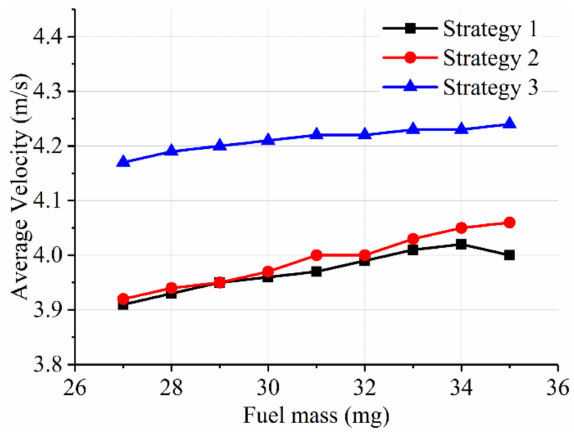
Figure 18. Phase trajectory of control strategies.